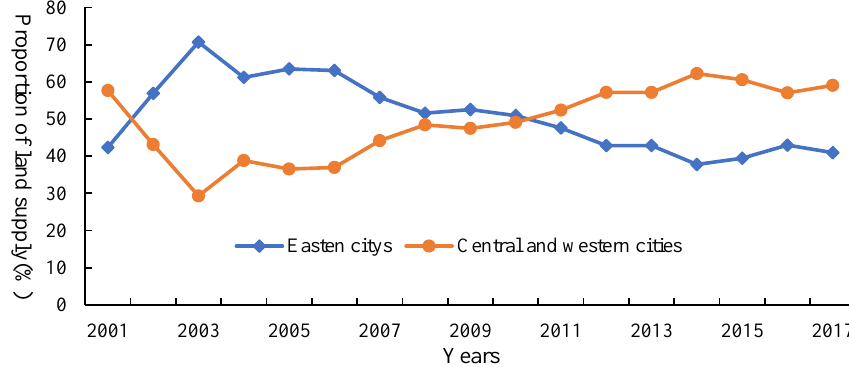
Figure 1. The trend of land supply area proportion.